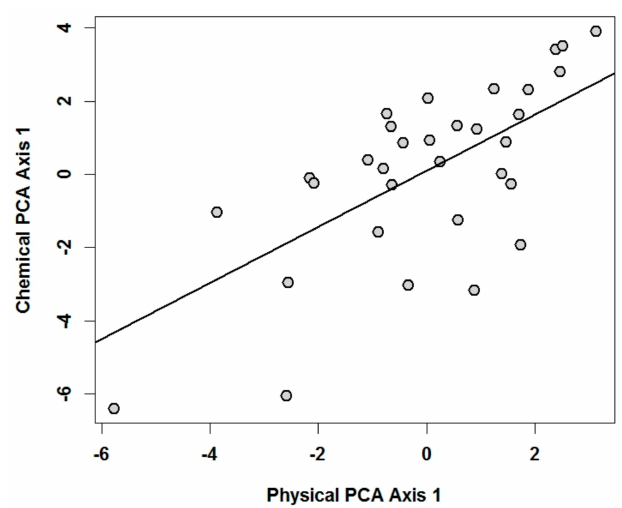
Figure 1. Relationship of the site scores of the first chemical PCA (principal components analysis) axis with site scores of first physical PCA axis in eight agricultural headwater streams in Indiana, Michigan, and Ohio, 2017 to 2018. The straight line in the figure is the predicted relationship calculated based on the equation y = 0.092 + 0.766 (physical PCA axis